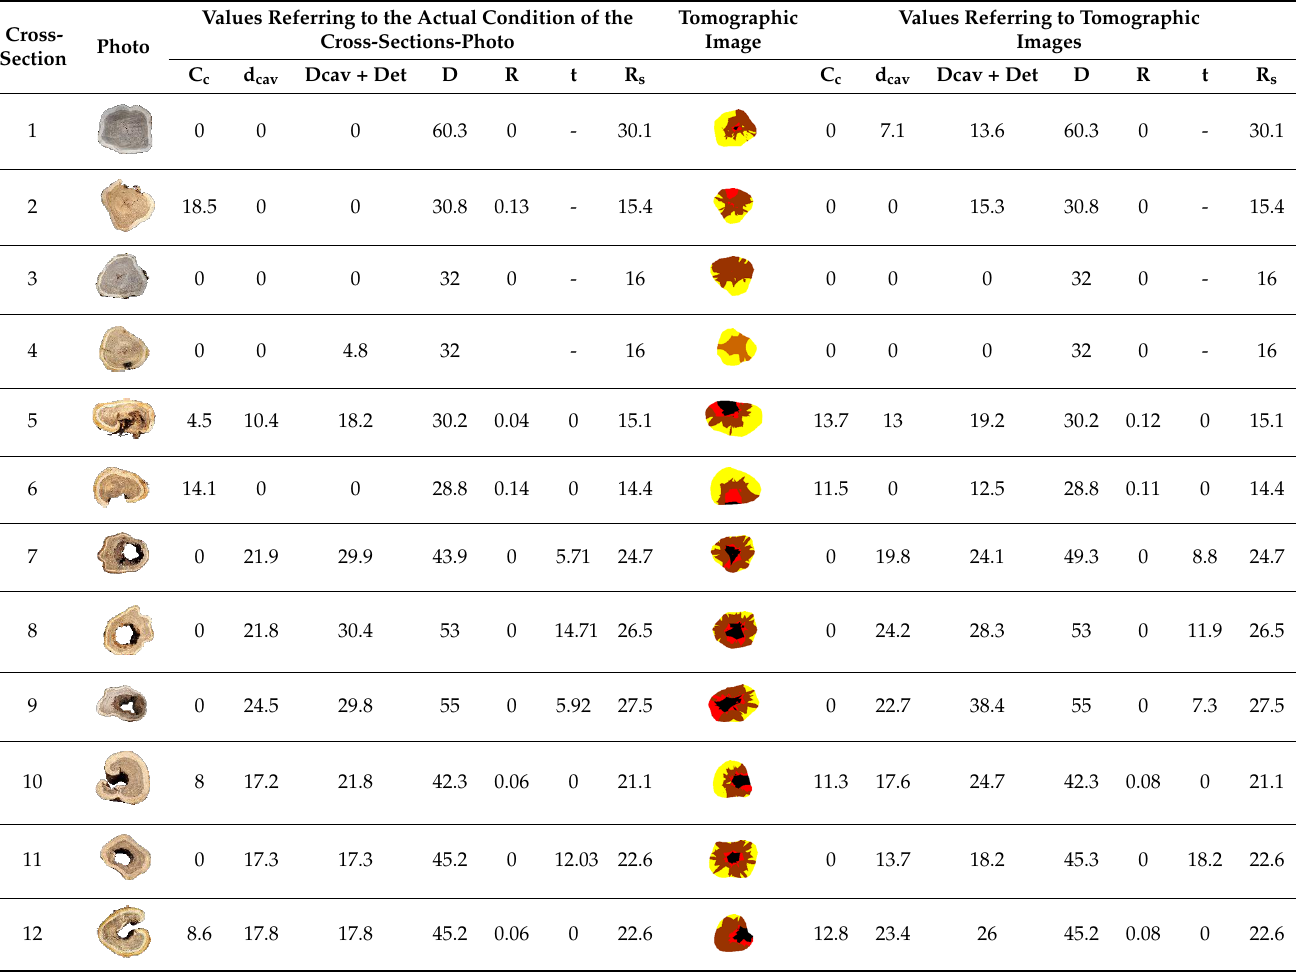
Table 1. Parameters calculated from the actual condition of the cross-sections (picture) and tomo- graphic image.